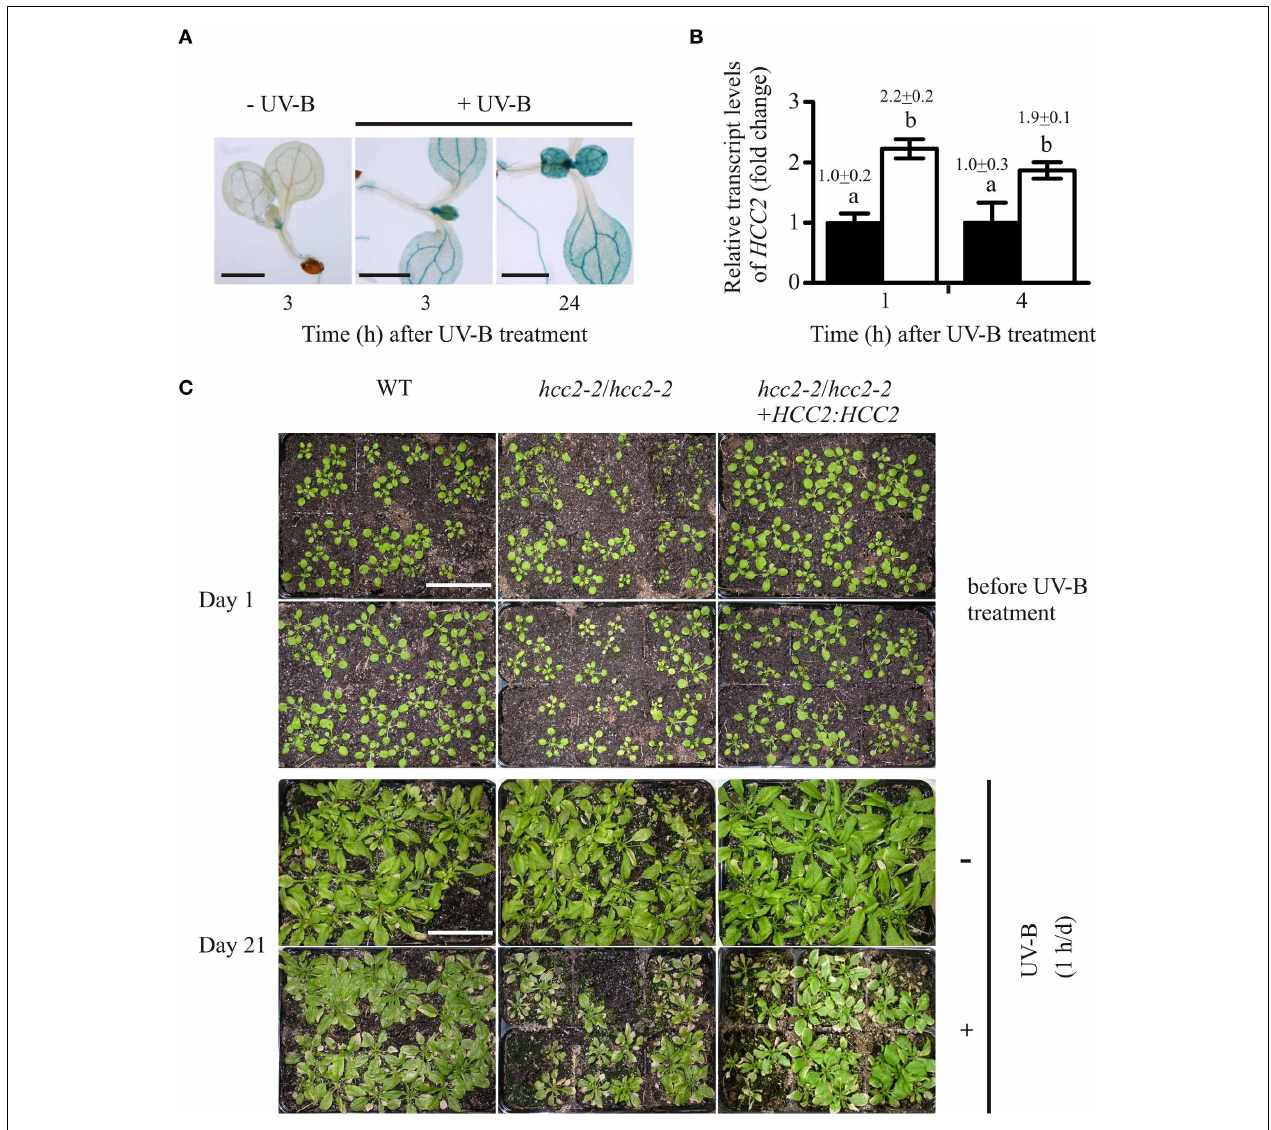
FIGURE 6 | Response of hcc2 mutants and WT to UV-B treatment. (A) HCC2:GUS seedlings were stained for GUS activity 3h or 24h after a 1-h treatment with UV-B light. Untreated seedlings were stained in parallel to the 3-h time point. Two GUS lines (lines 3 and 7) were included in the experiment, and three seedlings were photographed per time point. Here seedlings of the line 3 are shown. The experiment was repeated once providing the same staining pattern. The scale bars equal 1mm each. (B) The relative amounts of HCC2 transcripts were analyzed in 14-day-old WT seedlings by qRT-PCR which were either treated with UV-B for 1h (white bars) or left untreated (black bars). RNA was isolated from leaves harvested at the indicated time points. The amounts of HCC2 transcripts at time point 1h of the untreated control were set to 1. PP2AA3 transcript levels were used as a reference for normalization. Error bars represent standard deviations calculated from the normalized HCC2 expression